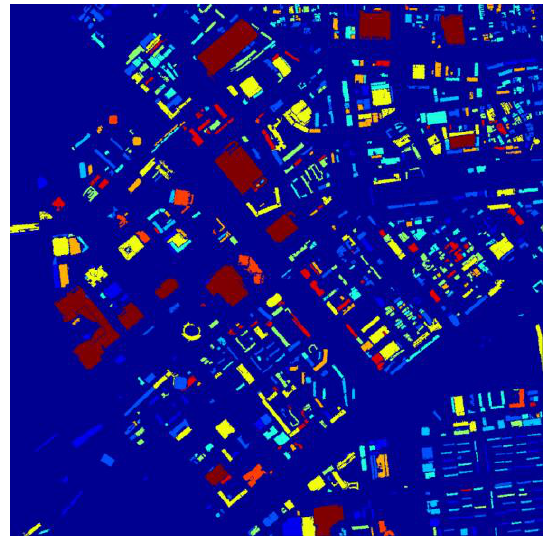
Figure 17. Building classification result using NRCS values and the number of roof segments (2)